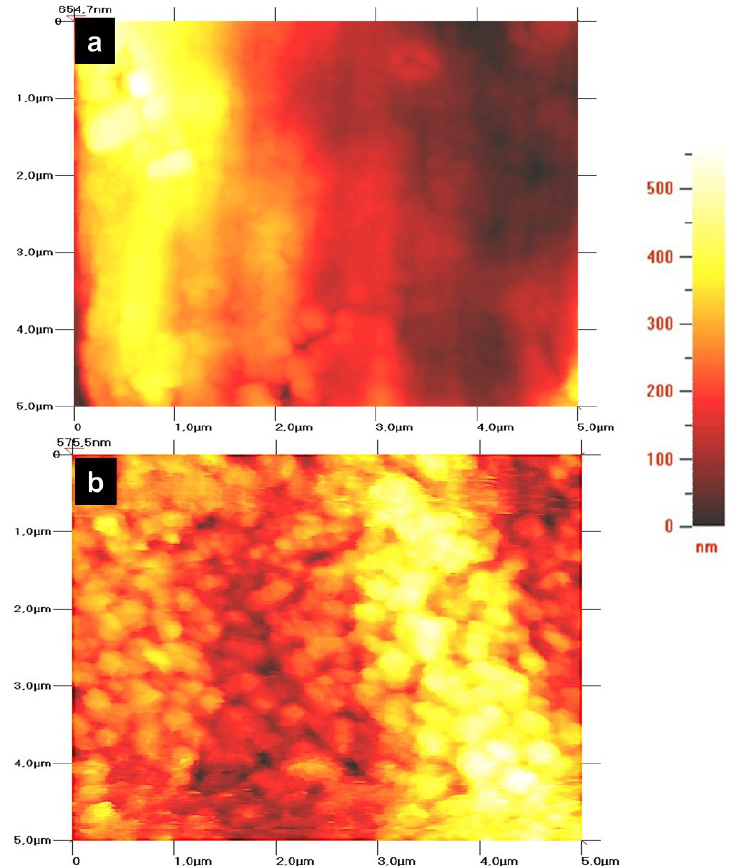
Figure 2. AFM micrographs of the Ti6Al4V alloy surface. ( a ) Non-anodized Ti6Al4V alloy, showing a smooth surface; ( b ) anodized Ti6Al4V alloy, showing a rougher surface. The scan area is 25 µm 2 . The color bar represents the surface